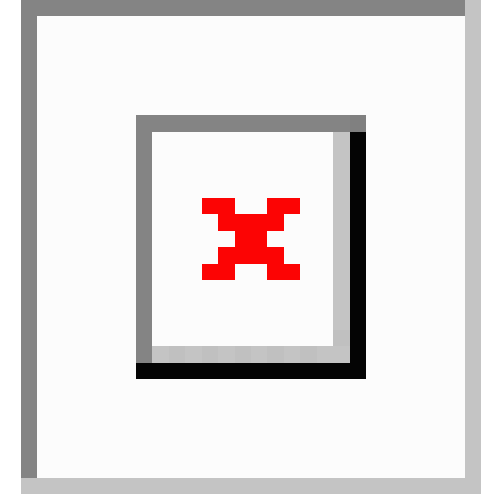
Figure 1. The overall size M can be written in terms of a finite geometric series, where N is the number of downsampling